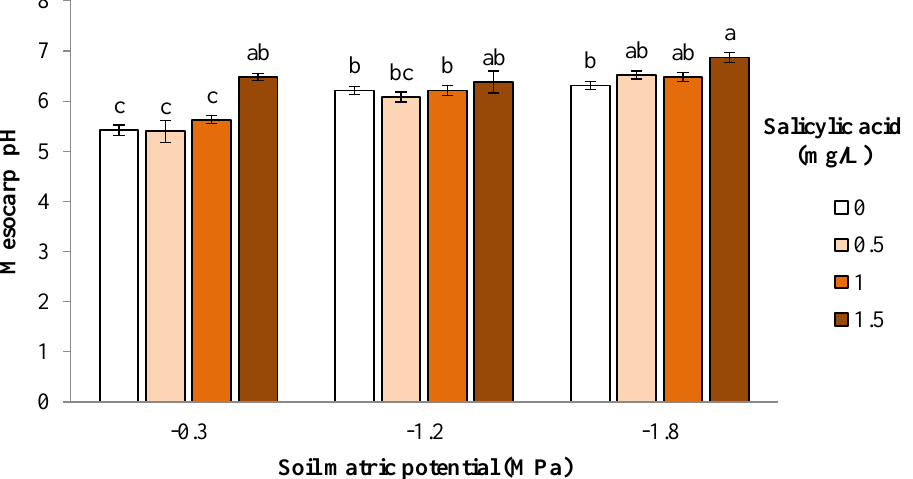
Figure 3. Interaction effects of controlled water stress and foliar application of SA on mesocarp pH of Pumpkin.